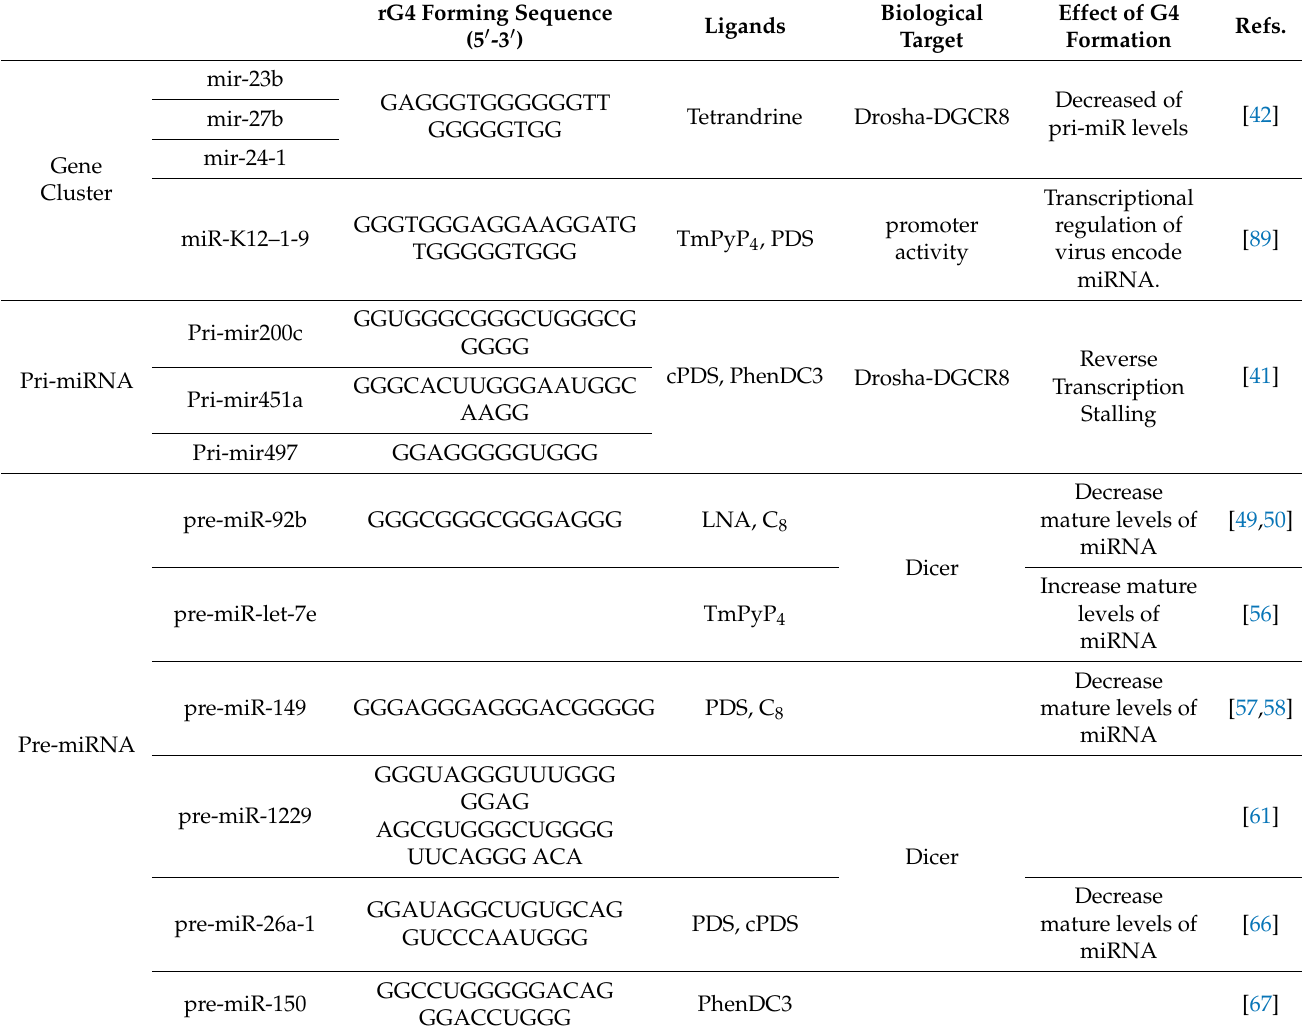
Table 1. List of G4 sequences in ncRNA nucleic acids discussed in this review. rG4 Forming Sequence (5 (cid:48) -3 (cid:48) )